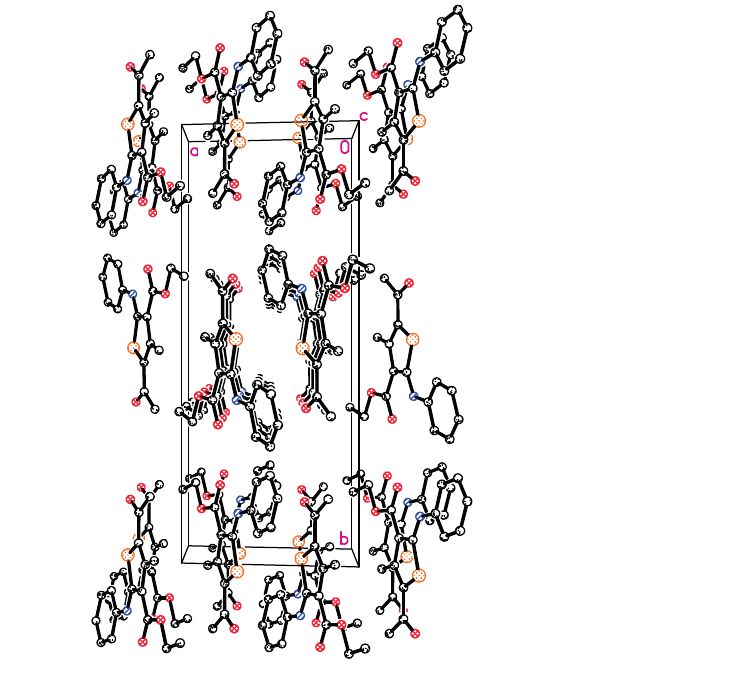
Figure 2. The packing diagram of compound 2 in the crystal lattice. Hydrogen atoms not involved in intermolecular hydrogen bonding are omitted for